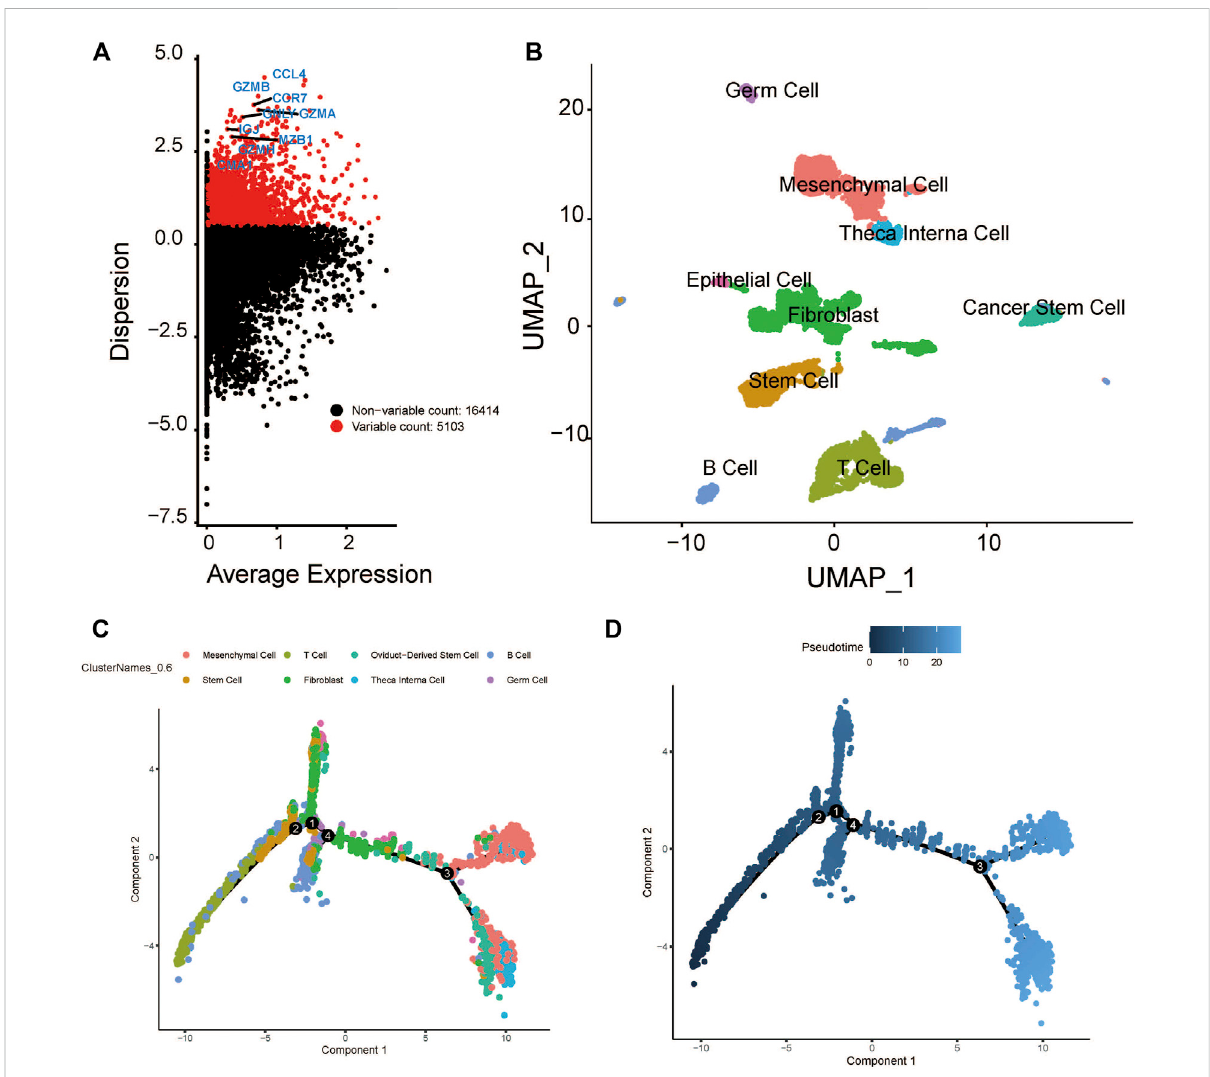
FIGURE 2 Clusteridenti fi cationandpseudotimeanalysisoftheHNSCCscRNAdataset. (A) Genevariationplotofthedataset,whereeachdotisageneand thereddotsrepresentgeneswithvariableexpression. (B) UMAPplotofHNSCCcellclusters,whichareannotatedasBcells,epithelialcells, fi broblast, germ cells, mesenchymal cells, cancer stem cells, stem cells, T cells, and theca interna cells. (C) Trajectory plot of the dataset, where each cluster (represented by each of the dots) is indicated by a different color. (D) Trajectory plot of the dataset, where the color of the dot indicates the differentiation state. The darker dot indicate a lower level of differential